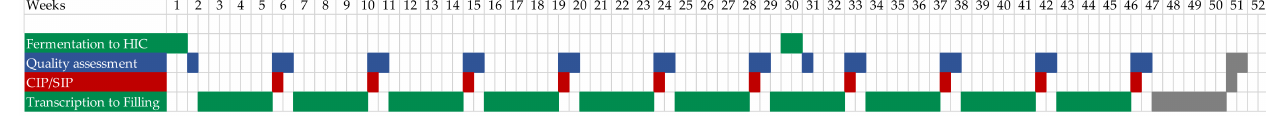
Figure 5. Continuous mRNA production schedule.